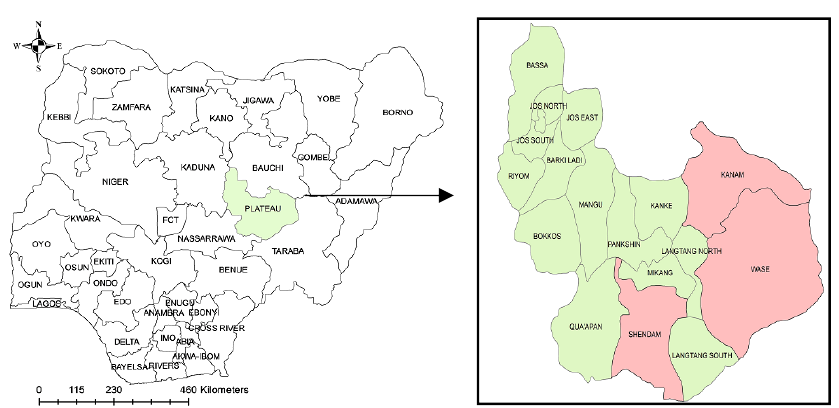
Figure 1. Map of Nigeria showing Plateau State in green. The study regions (three local governments) are in pink colour.